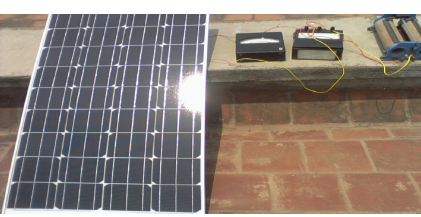
Figure 2: Photovoltaic panel under